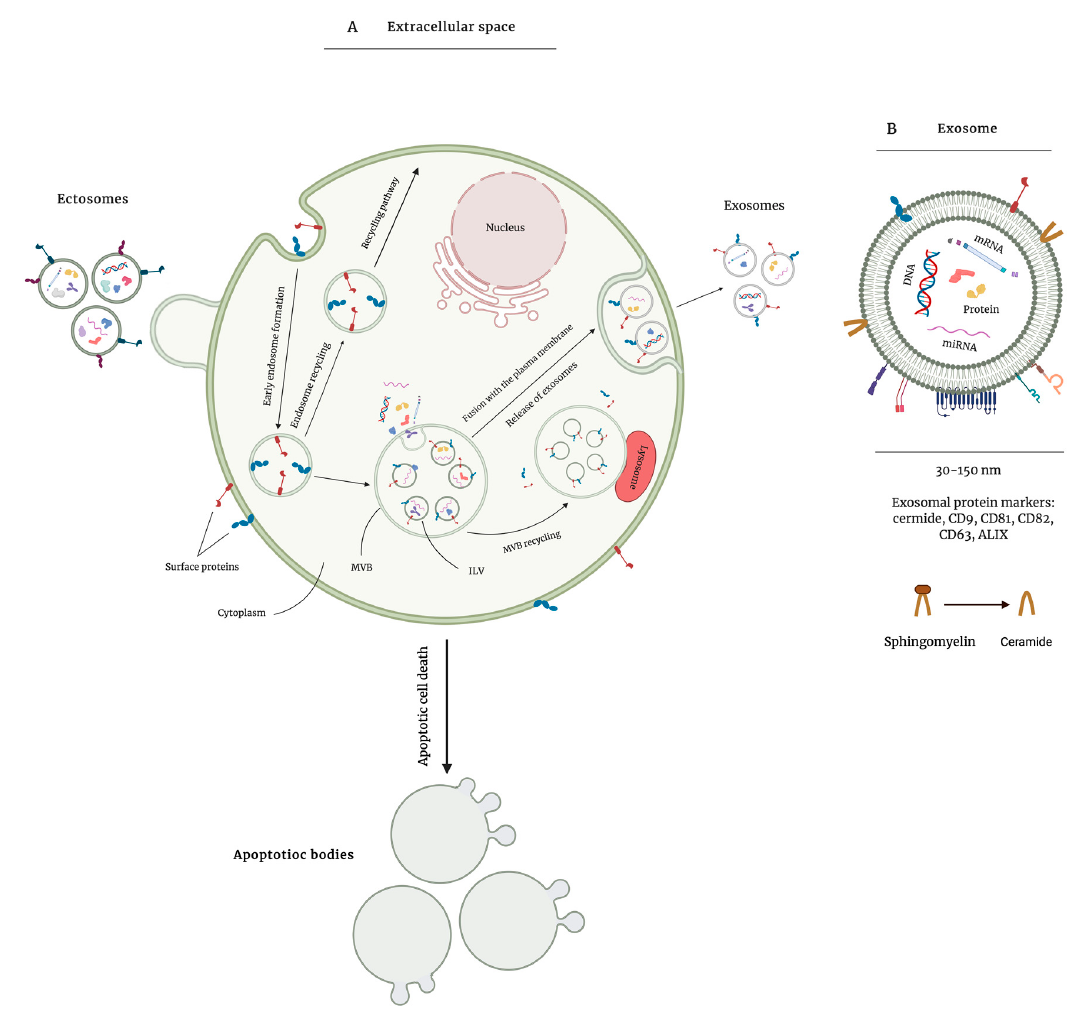
Figure 2. Overview of extracellular vesicle (EV) biogenesis. EVs are lipid bilayer vesicles that are secreted by almost all cell types and are associated with mediating biological processes. There are three types of EVs based on their biogenesis, morphology, size, and isolation method. EVs are most commonly isolated via differential ultracentrifugation at different speeds. Apoptotic bodies, as the largest group of EVs, are secreted by cells undergoing apoptosis and are pelleted at ~2000 × g . Ectosomes are formed through outward blebbing of the plasma membrane and are pelleted at ~10,000 × g ( A ). Exosomes are formed through invagination of the multivesicular bodies with the plasma membrane and contain several biomolecules such as proteins, DNA, and different types of RNA. They include CD9, CD81, CD63, and ALG-2-interacting protein X (ALIX) as surface protein markers and are pelleted at high speed ultracentrifugation ( B ).